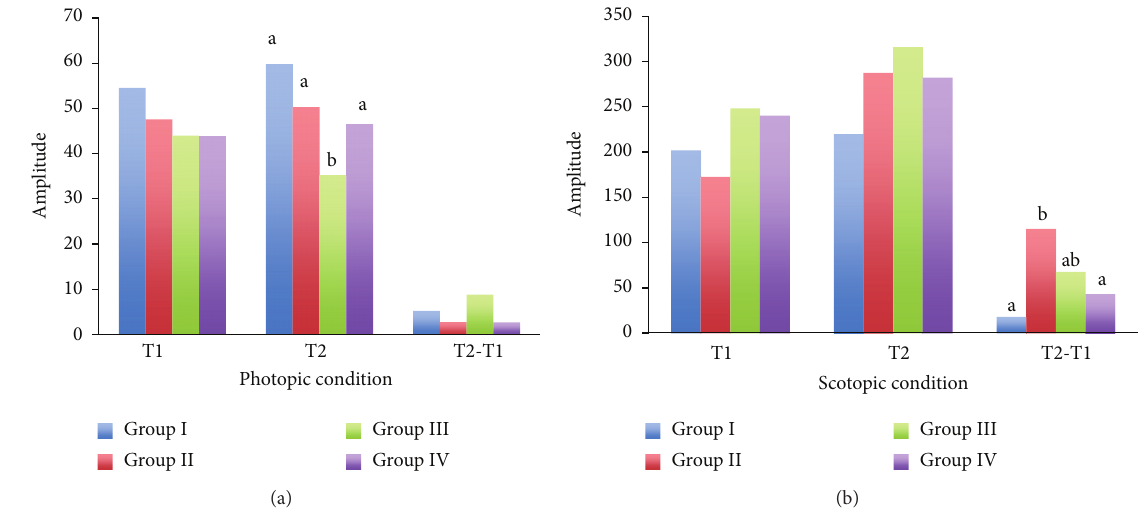
Figure 3: The electroretinogram (ERG) was performed on the control (Group I), diabetes (Group II), and diabetes + taurine (Group III, Group IV) groups on week 5 (T1) and week 15 (T2). The averaged b-wave amplitude under the photopic (a) and scotopic (b) conditions was recorded and analyzed. a, b: bars with different alphabetic letters differ ( 𝑃 < 0.05 ).